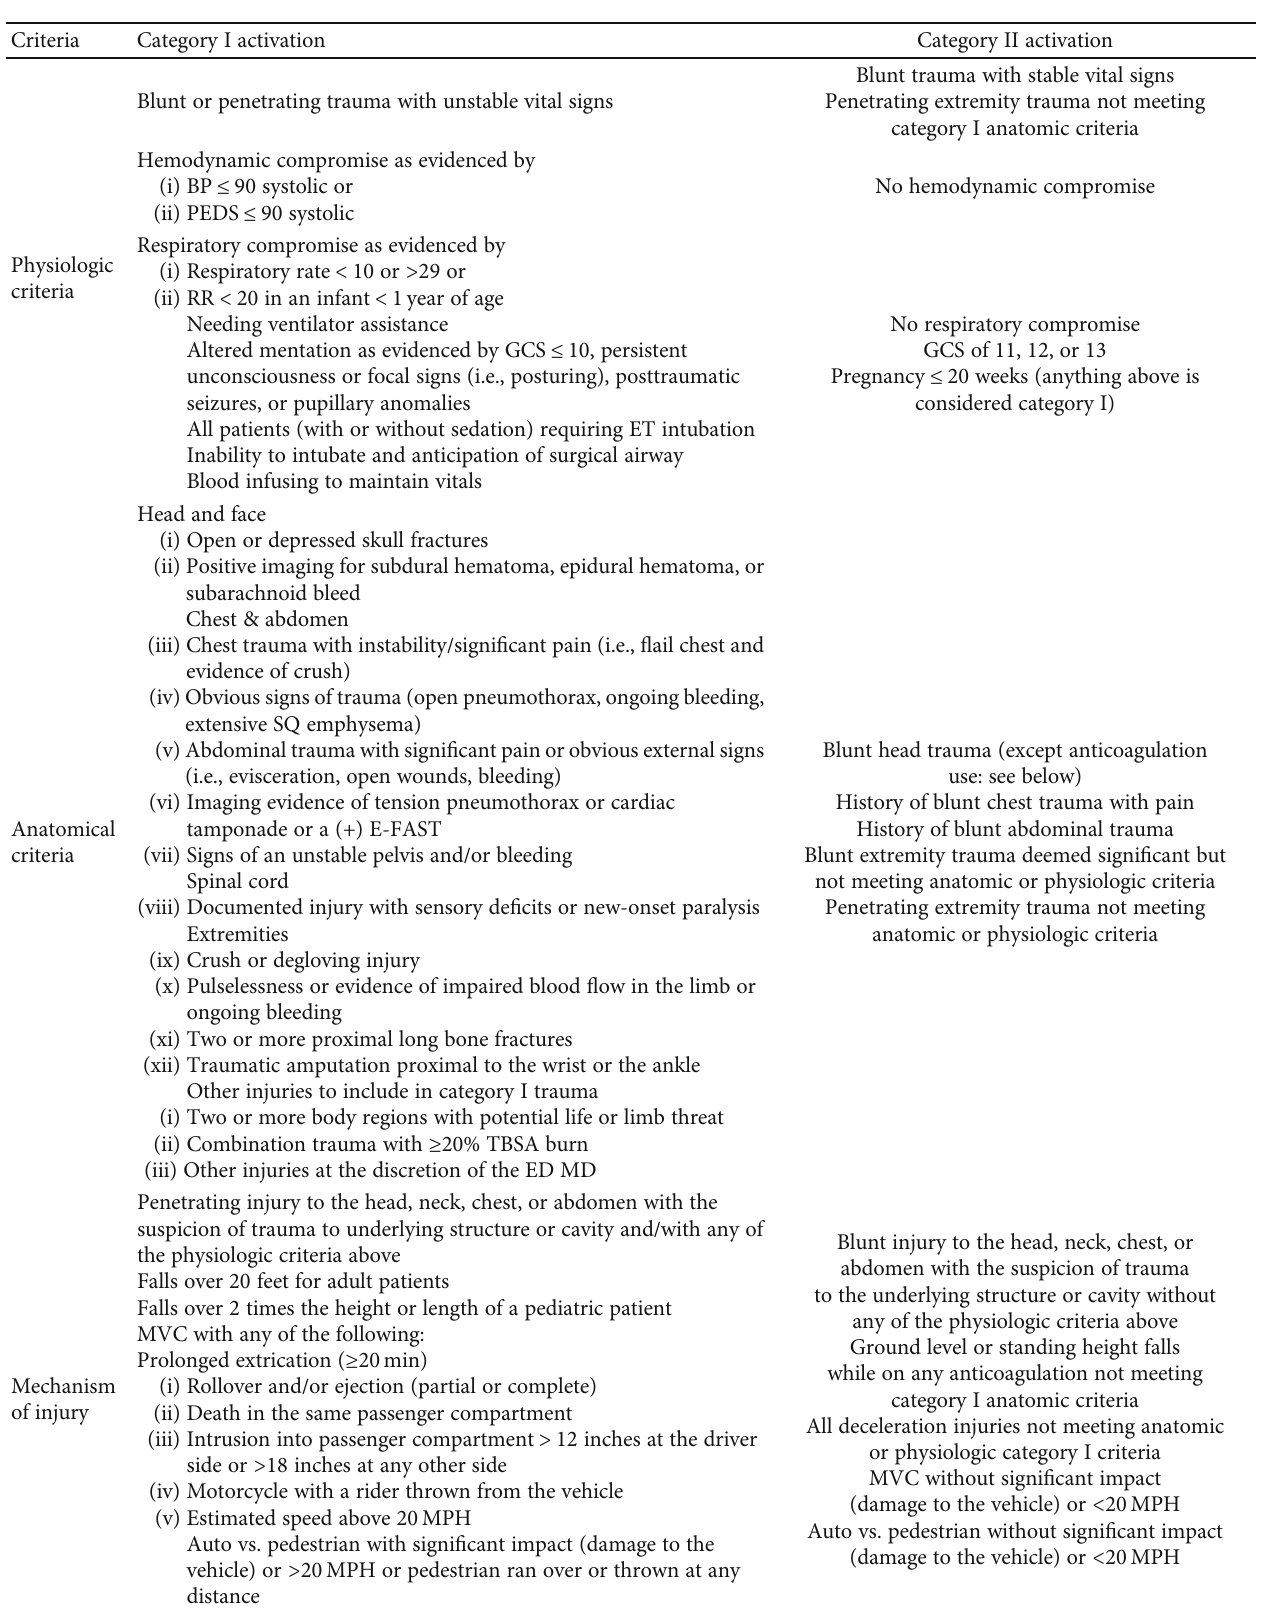
Table 1: Activation